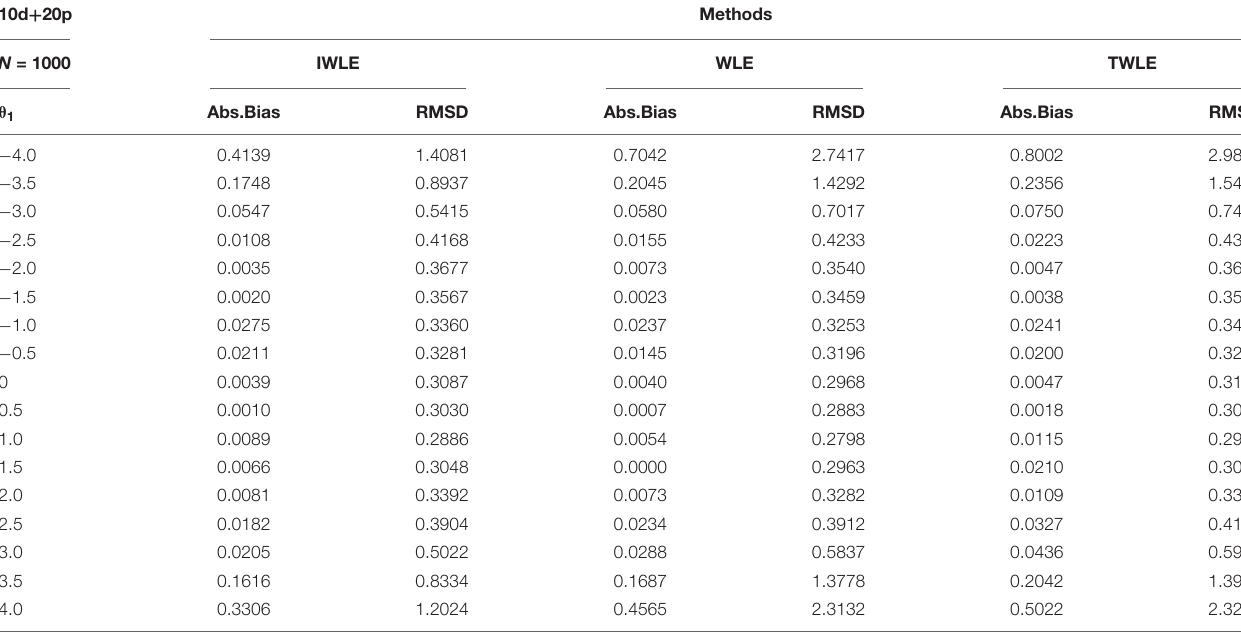
TABLE 6 | Absolute bias and root mean squared difference for WLE, TWLE, and IWLE at 17 different levels of initial ability for 10 d + 20p.